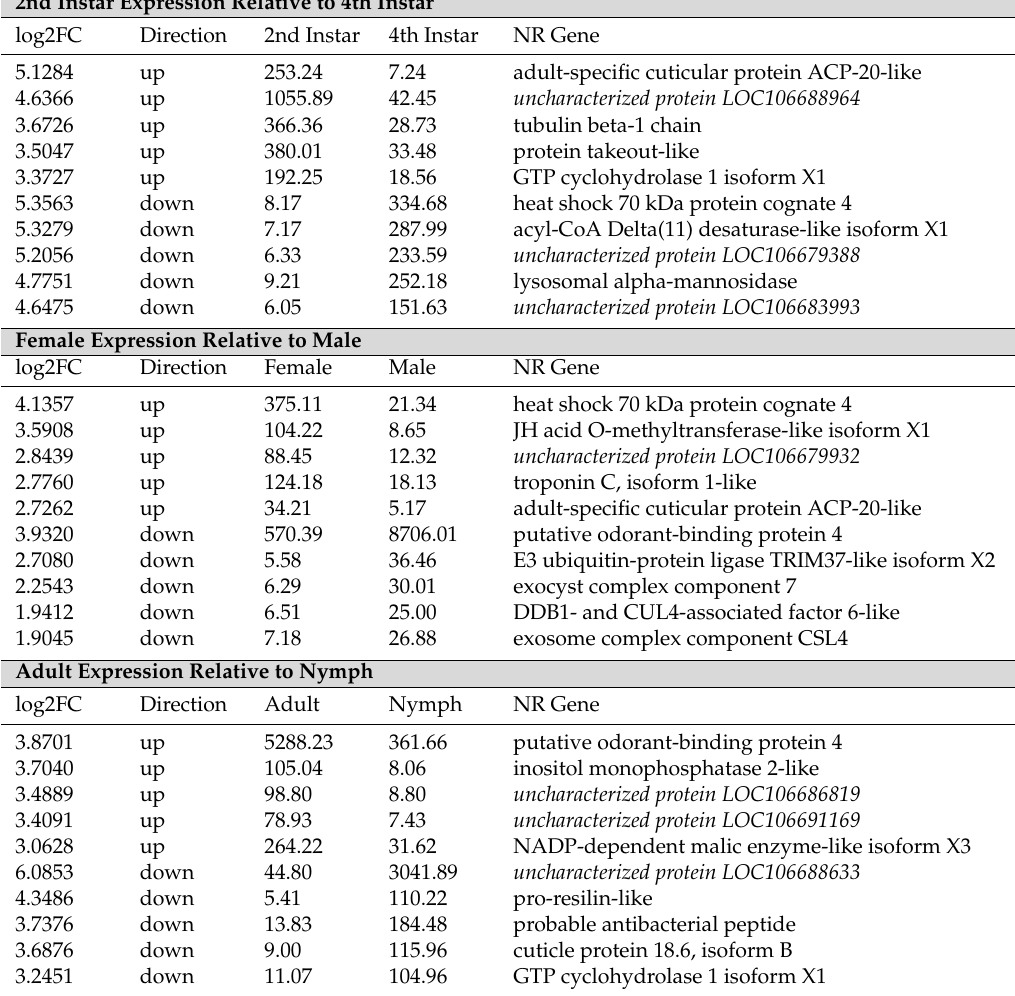
Table 3. Gold-tier transcripts exhibiting the greatest gene expression fold changes within each of the three harlequin bug mRNA population comparisons performed. Expression levels were conveyed using the Transcripts Per Million (TPM) measure, and binary logarithms were used to rank sample-specific ratios of these amounts. A floor on TPM values of 5.0 was